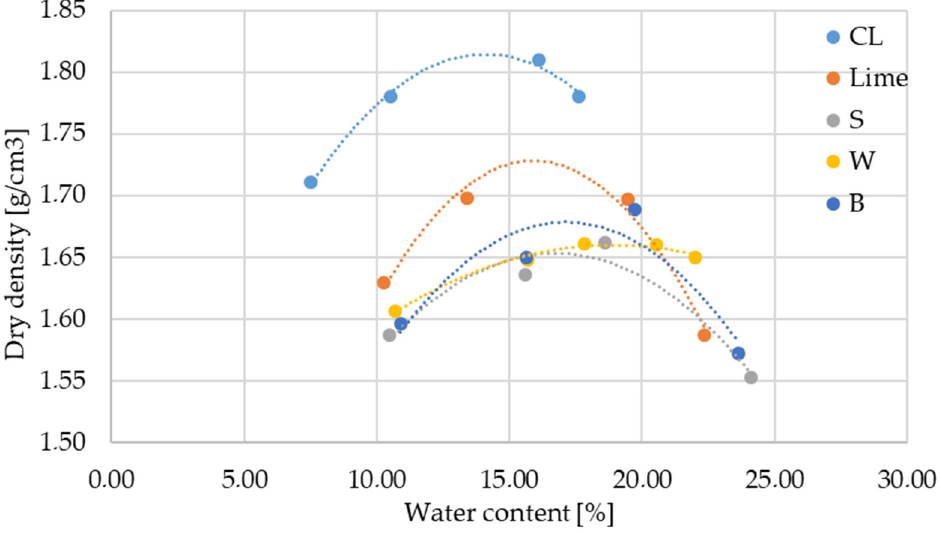
Figure 3. Standard Proctor compaction test results.